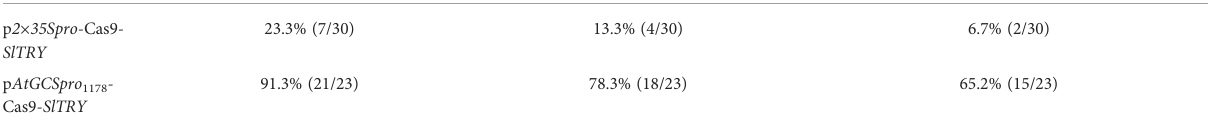
TABLE 5 Comparison of p AtGCSpro 1178 -Cas9 -SlTRY and p2× 35Spro -Cas9 -SlTRY genome editing ef fi ciency in tomato hairy roots. Cas9 system H/BM rate at target site 2 (no. of H/BM rate at both target sites 1 and 2 roots with H/BM at target site 2/ no. of roots examined)